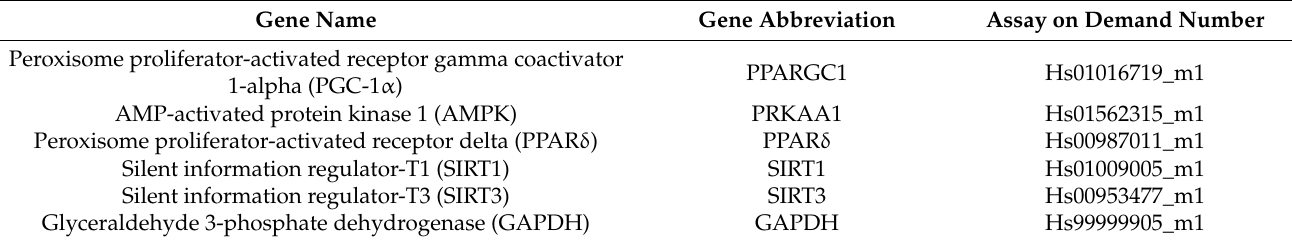
Table 3. Taqman Assays on Demand information (Applied Biosystems).